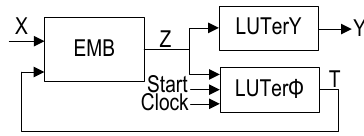
Figure 5. Structural diagram of Mealy FSM U 4